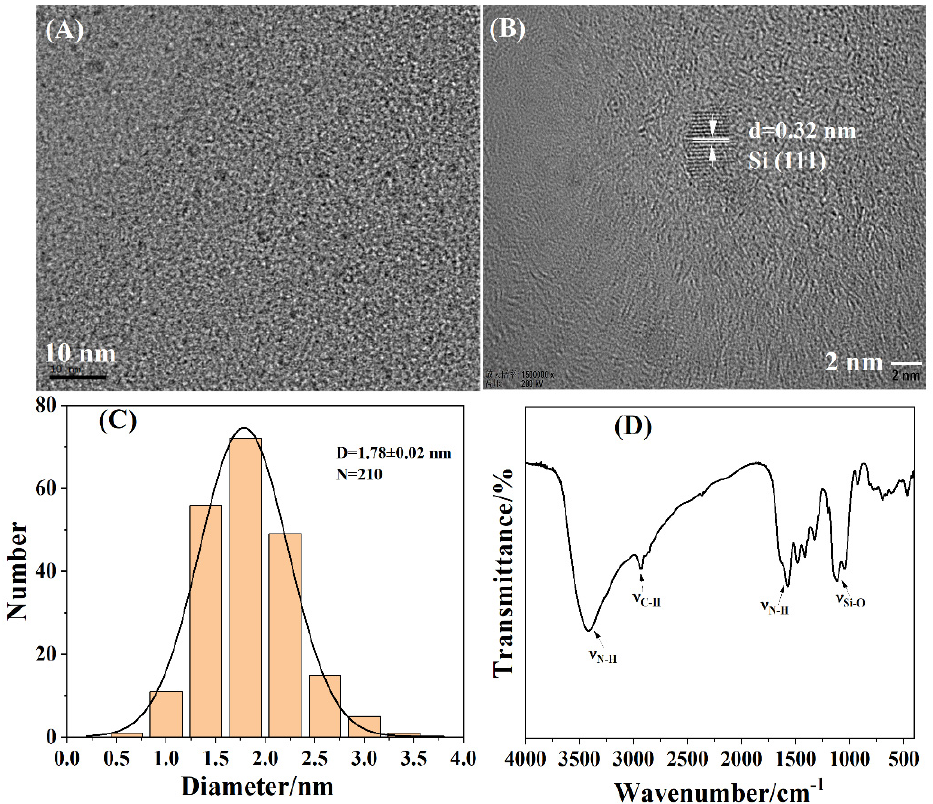
Figure 1. Structural characterizations of the as-prepared SiNPs: ( A ) TEM images; ( B ) HRTEM images; ( C ) size distribution histogram; ( D ) FTIR spectrum.